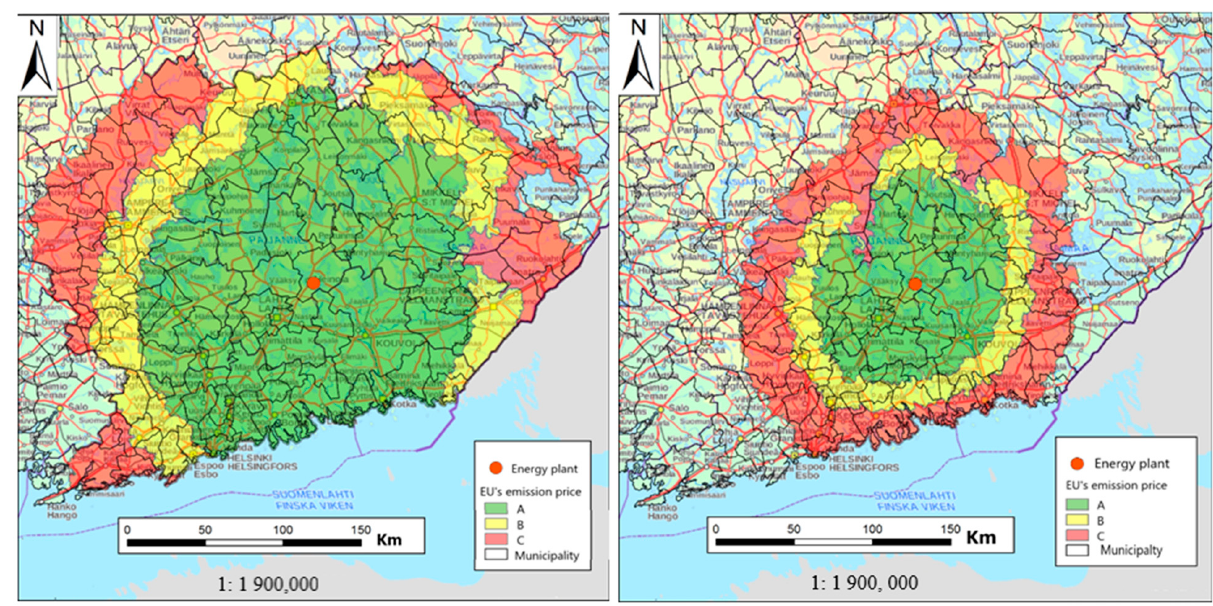
Figure 4. Wood procurement areas of an energy plant of IEMI in renewable carbon sinks ( left figure) and in declining carbon sinks ( right figure). A = 98 € t − 1 CO 2 , B = 65 € t − 1 CO 2 , C = 30 € t − 1 CO 2